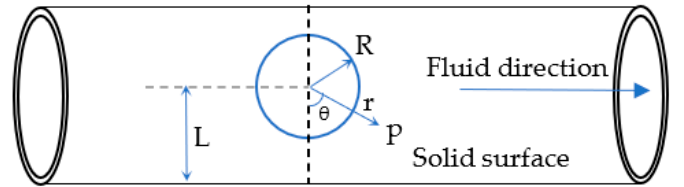
Figure 1. Bubble movement and pressure angle [31].